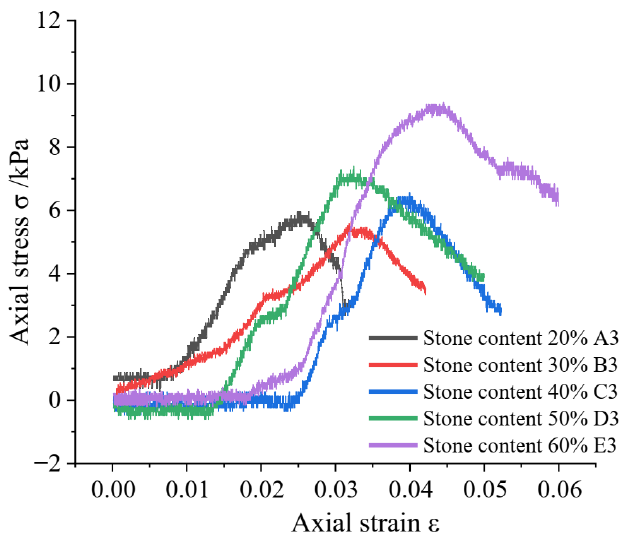
Figure 5. Stress–strain curve of soil–rock mixture stone with particle sizes of 0.6–0.9 cm.